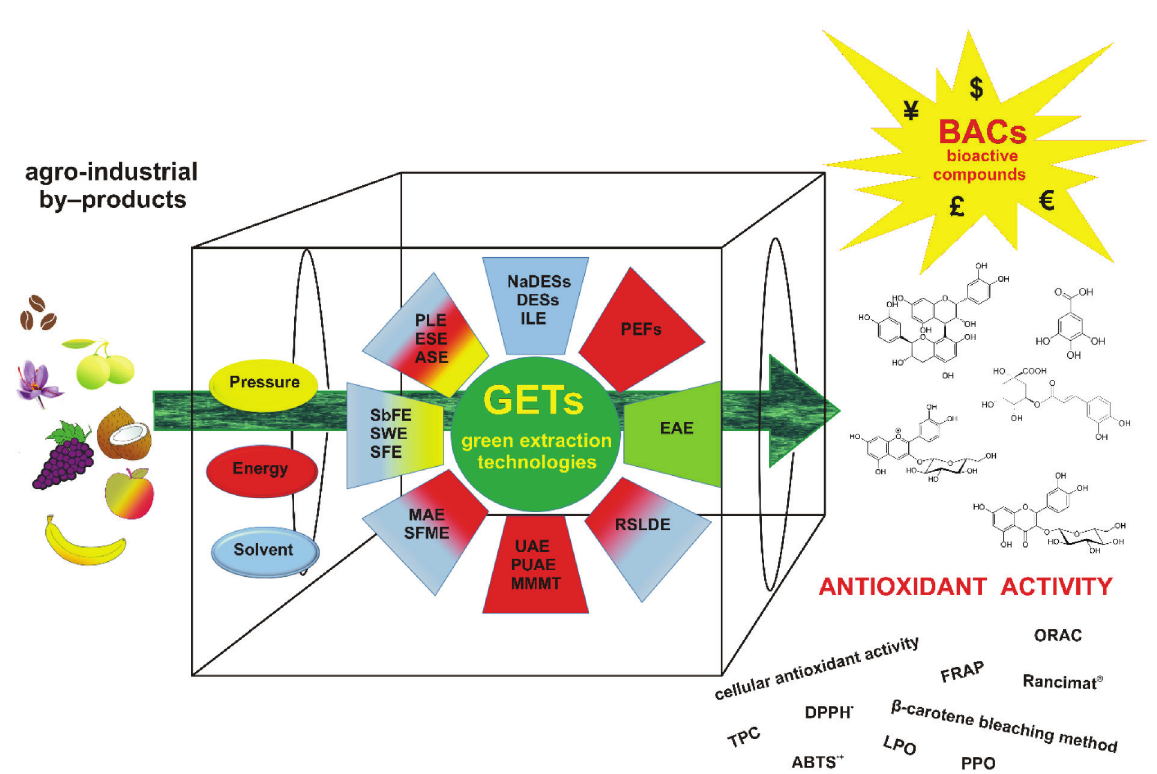
Fig. 3 – From agro-industrial by-products to bioactive compounds with antioxidant activity (for the abbreviations, see the list at the end of the